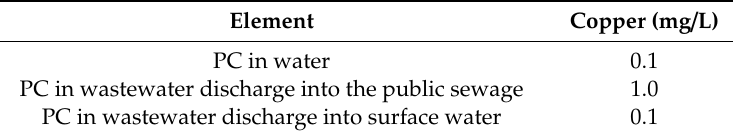
Table 2. USEPA Permissible Concentration (PC) for copper in water [45].